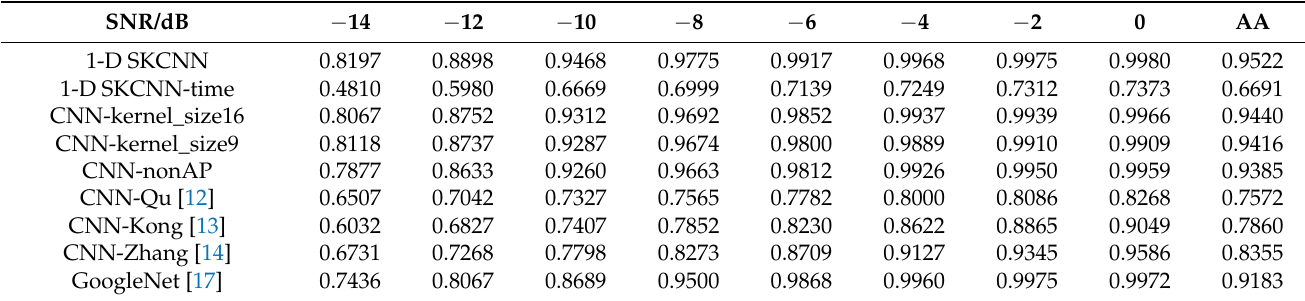
Table 6. The time usage for training the model in different methods.